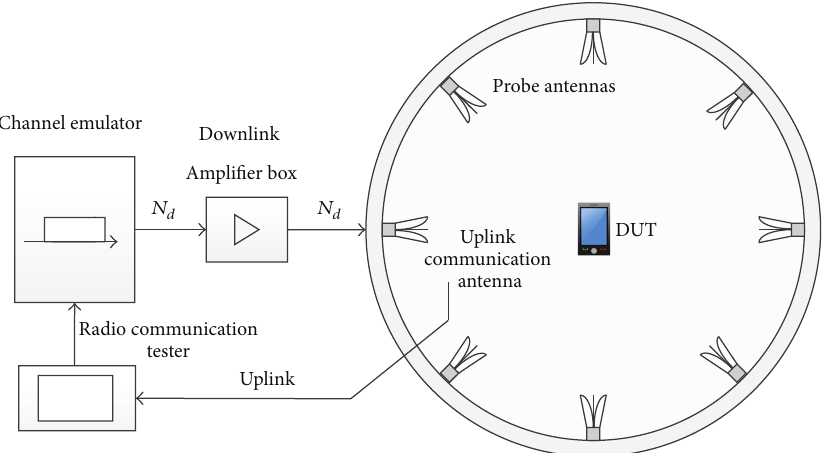
Figure 1: An illustration of MPAC setups in the standards. 𝑁 𝑑 is the number of probes used for the downlink. The probes and the channel emulator are used to emulate downlink channel models. As for the uplink, a cable feeding directly to the radio communication tester is used and therefore fading of uplink channel is not